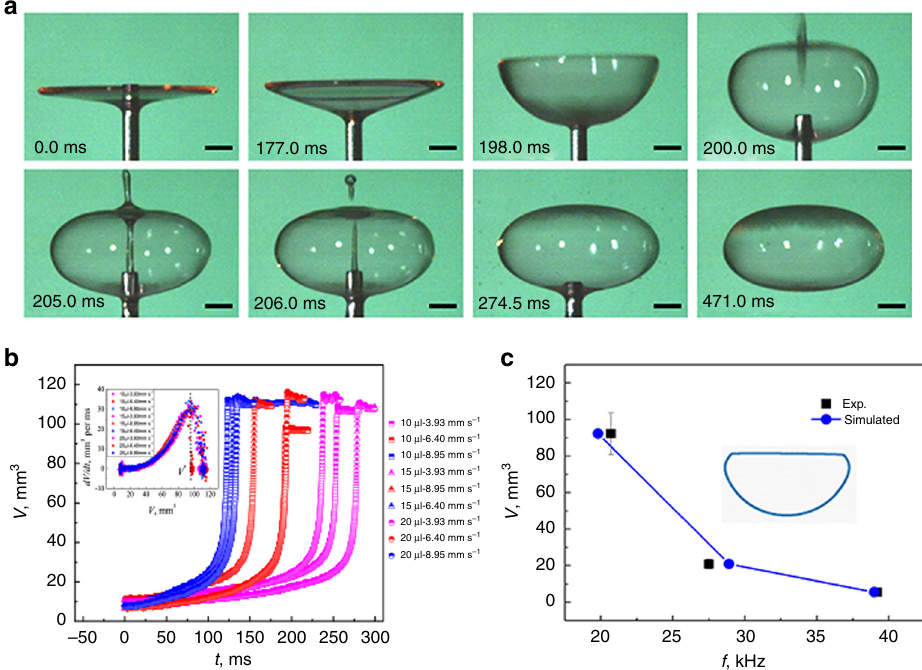
Fig. 4 Resonance mechanism for bubble formation of acoustically levitated drops. All the drops were SDS drops at CMC. a Snapshots showing that dragging a needle positioned at the center of the fi lm caused it to buckle, resulting in abrupt in fl ation and bubble formation. Each scale bar represents 1 mm. b Cavity volume V as a function of dragging time for liquid fi lms of different initial volumes (10, 15 and 20 µ L) and different dragging rates (3.93 – 8.95 mm/ s). Similar abrupt volume in fl ation was observed corresponding to the same critical cavity volume V * (see inset). c V * as a function of working frequency of the levitator; squares are experiment, circles are simulation. Inset image illustrates the contour line of the cavity corresponding to the maximum in fl ation rate for 20.7 kHz